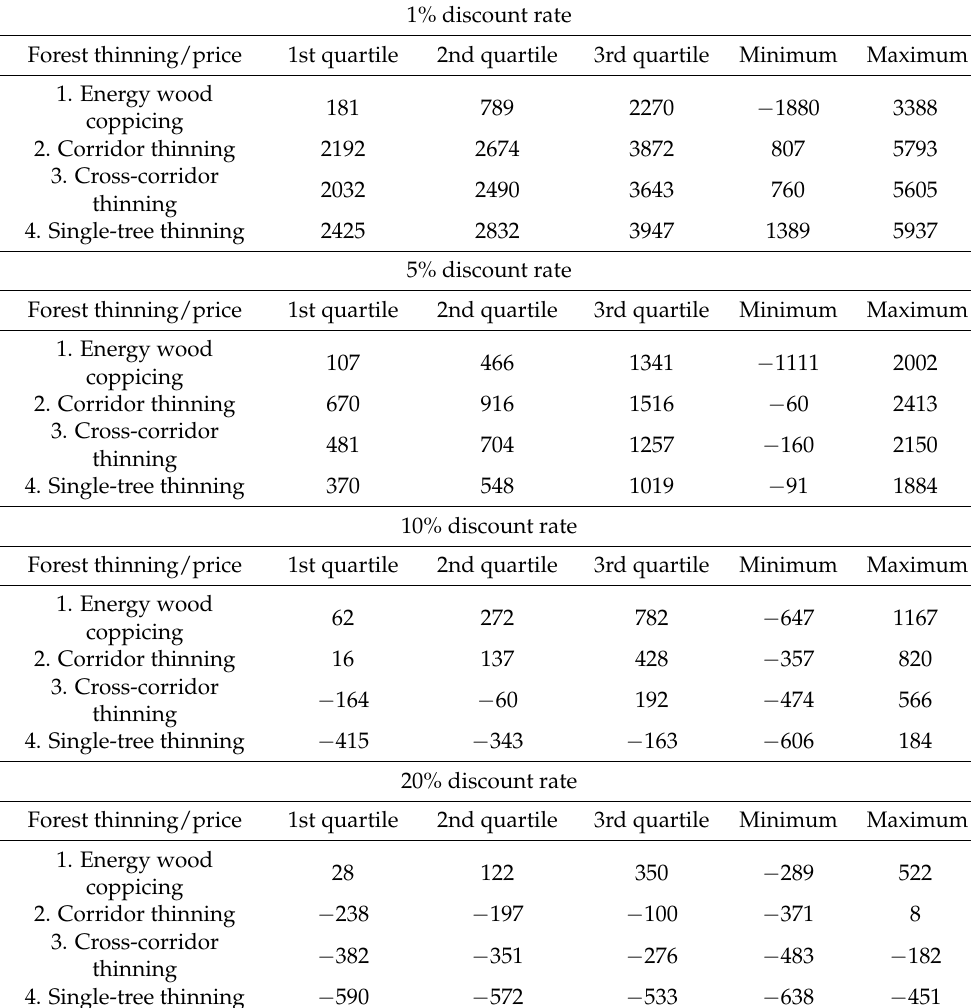
Table 5. Land expectation values (EUR ha − 1 ) from scenarios (subject to different forest thinning, price and discount rate